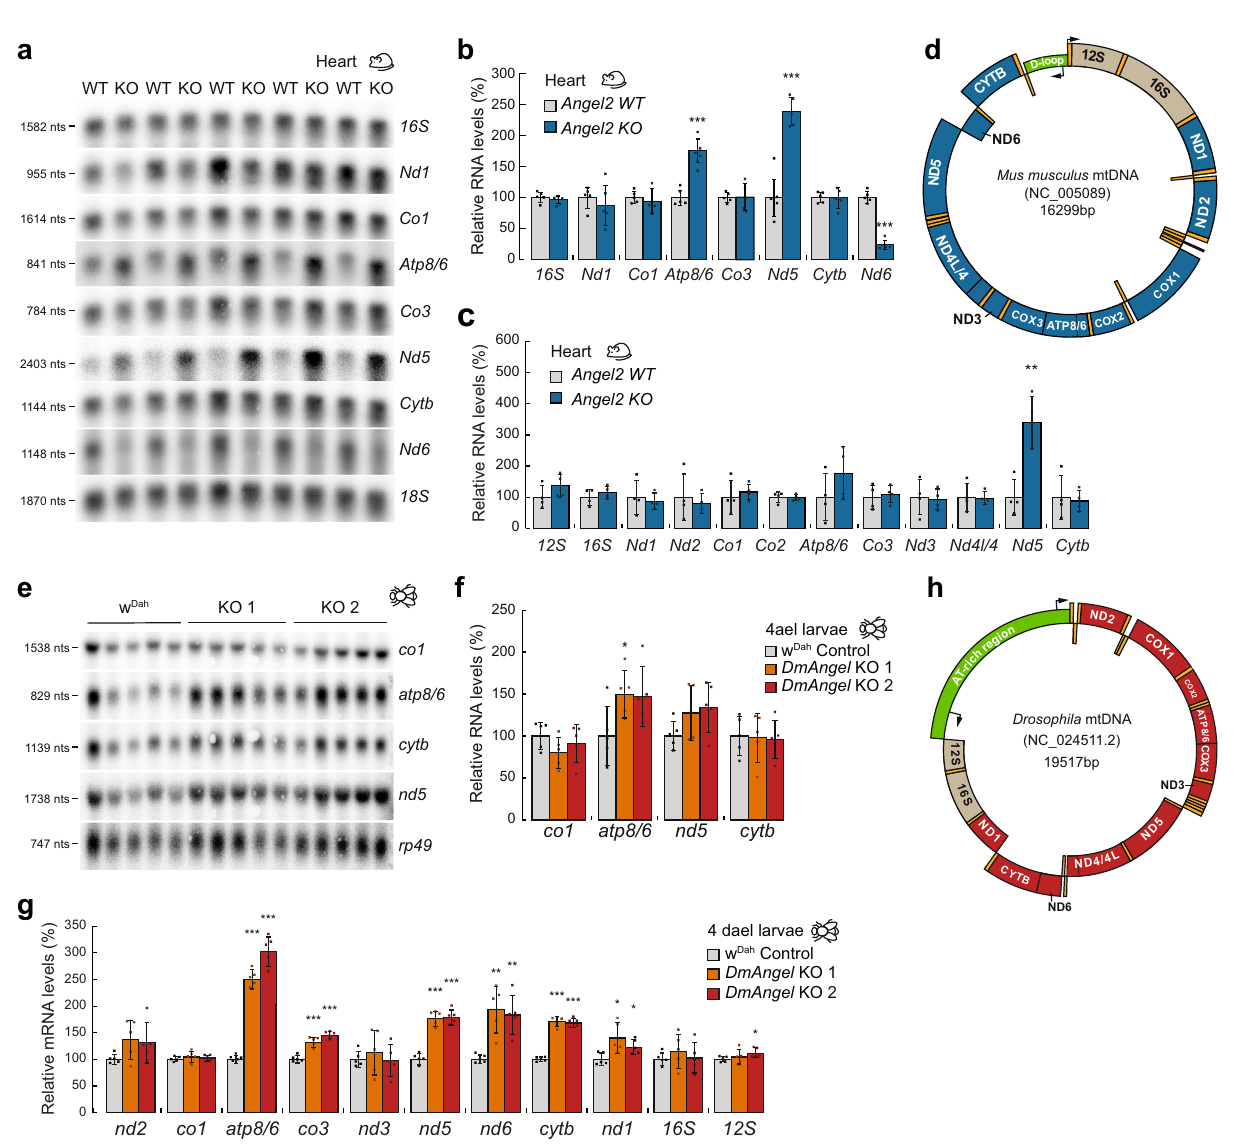
Fig. 2 | Deletion of DmAngel or MmANGEL2 affects mitochondrial gene expression. Relative mitochondrial transcript steady-state levels in 16-week-old mousehearts(blue; Angel2KO )andcontrols(lightgrey; Angel2WT) ,asdetermined by Northern blot analysis ( n =5 biologically independent samples) ( a , b ) or qRT- PCR( n =4biologicallyindependentsampleswith3technicalreplicas)( c ).18SrRNA was used as loading control. d Illustration of mouse mtDNA (NC_005089). Black arrows depict transcription initiation sites and tRNAs are indicated in orange.